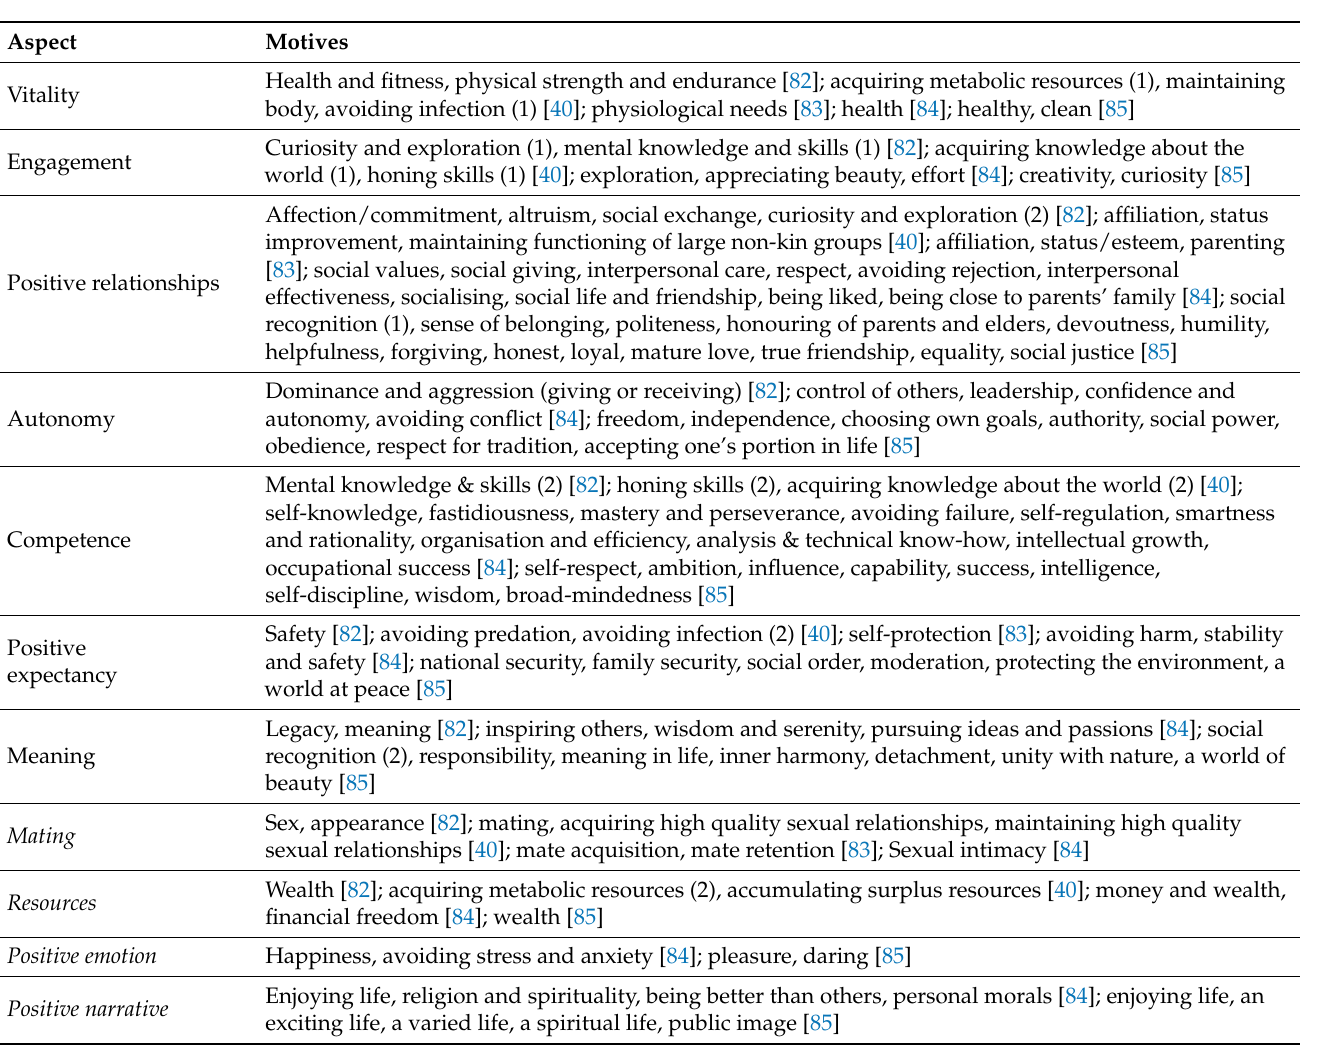
Table 3. Proposed links between wellbeing aspects and